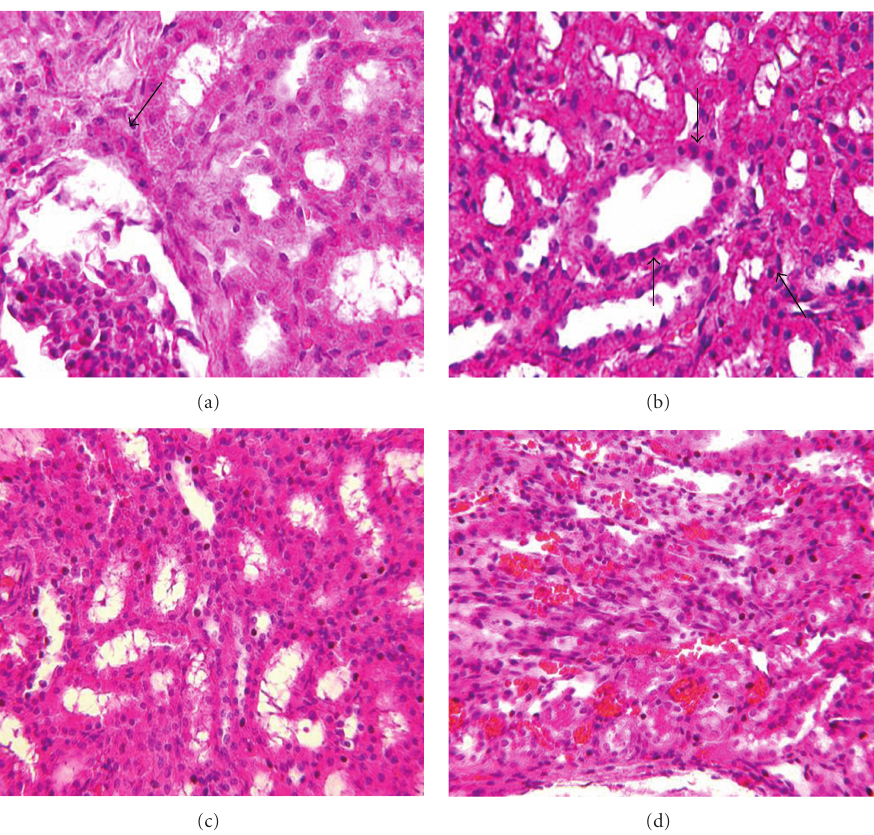
Figure 3: Histopathology of a kidney from a pig that received WBI 72 h previously of 700 cG and a further 1300 cGy with both kidneys shielded (H&E, magnification × 100). (a) A few passenger leukocytes can be detected in the interstitium (arrow). (b) A few apoptotic cells can be detected (arrows). (c) Minor hemorrhages are seen in the interstitium of medulla. (d) Congestion of peritubular blood vessels and interstitial edema can be